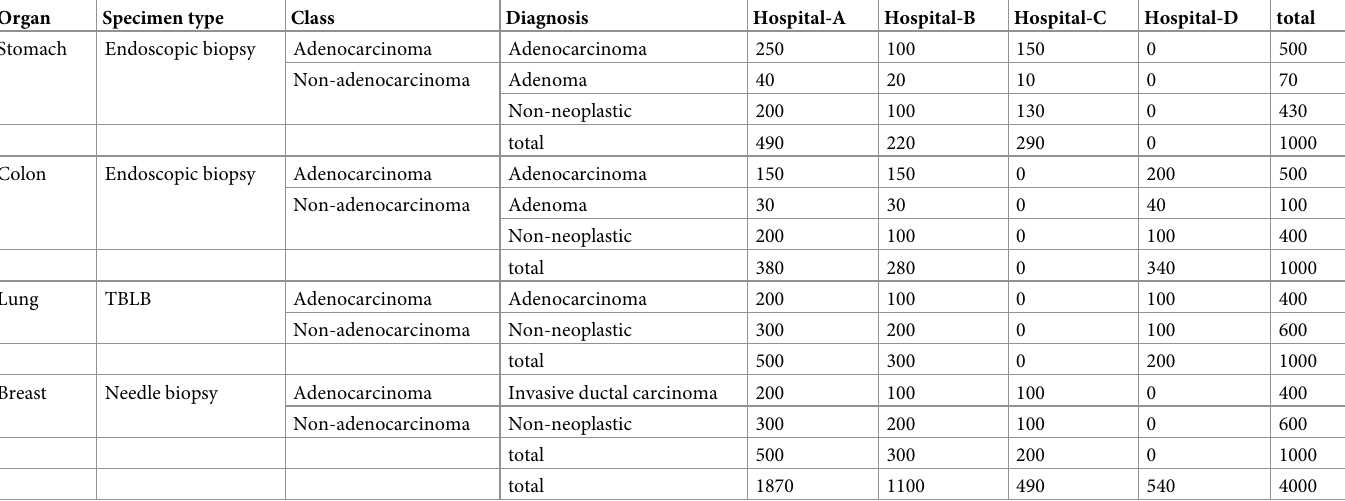
Table 1. Distribution of cases in the training sets obtained from different hospitals (A-D). Organ